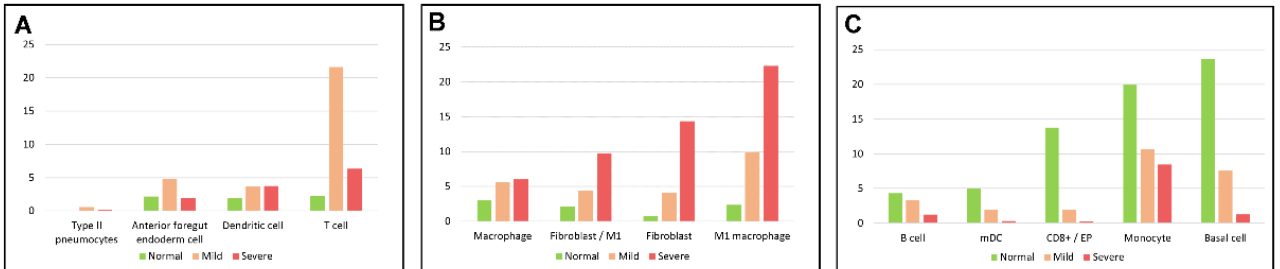
Figure 4. Trends of cell population changes in 13 cell types shared in the normal, mild, and severe groups with the Y -axis representing the percentage of cells in N, M, and S. ( A ) The proportion of cell types demonstrated a “ Λ ” shape in the normal, mild, and severe groups. ( B ) The proportion of cell types increased in the mild and severe groups. ( C ) The proportion of cell types decreased in the mild and severe groups.